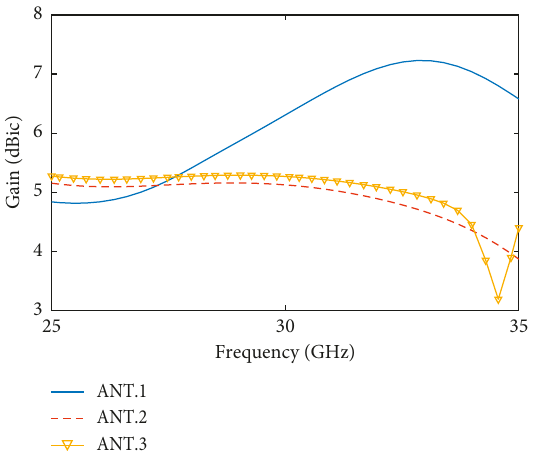
Figure 5: Simulated peak gain for ANT.1, ANT.2, and ANT.3.